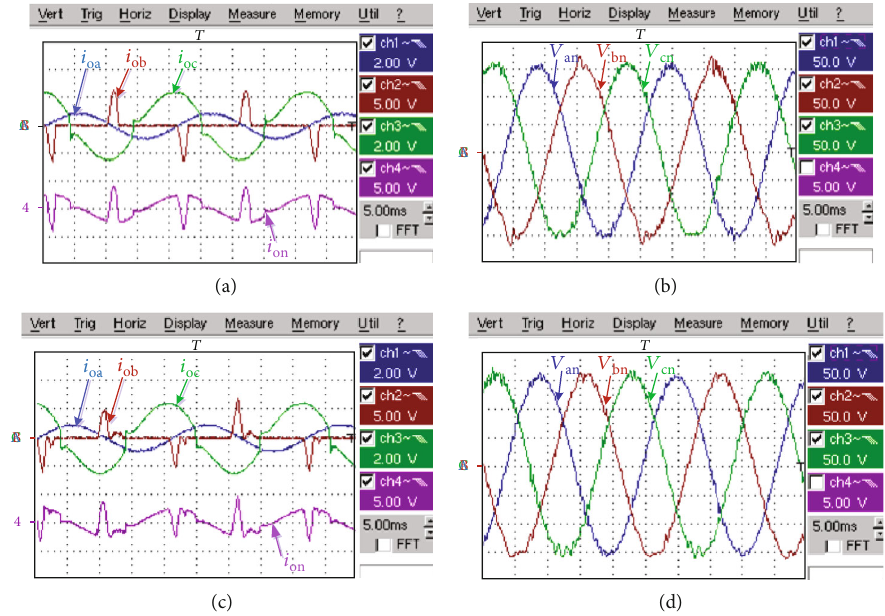
Figure 6: The experimental results under nonlinear load: DB controller: (a) load currents: ch1&ch3 (5.5 A/div) and ch2 &ch4 (13 A/div); (b) load voltages: ch1-ch3(50 V/div) and hybrid controller; (c) load currents: ch1 & ch3 (5.5 A/div) and ch2 & ch4 (13 A/div); (d) load voltages: ch1-ch3(50